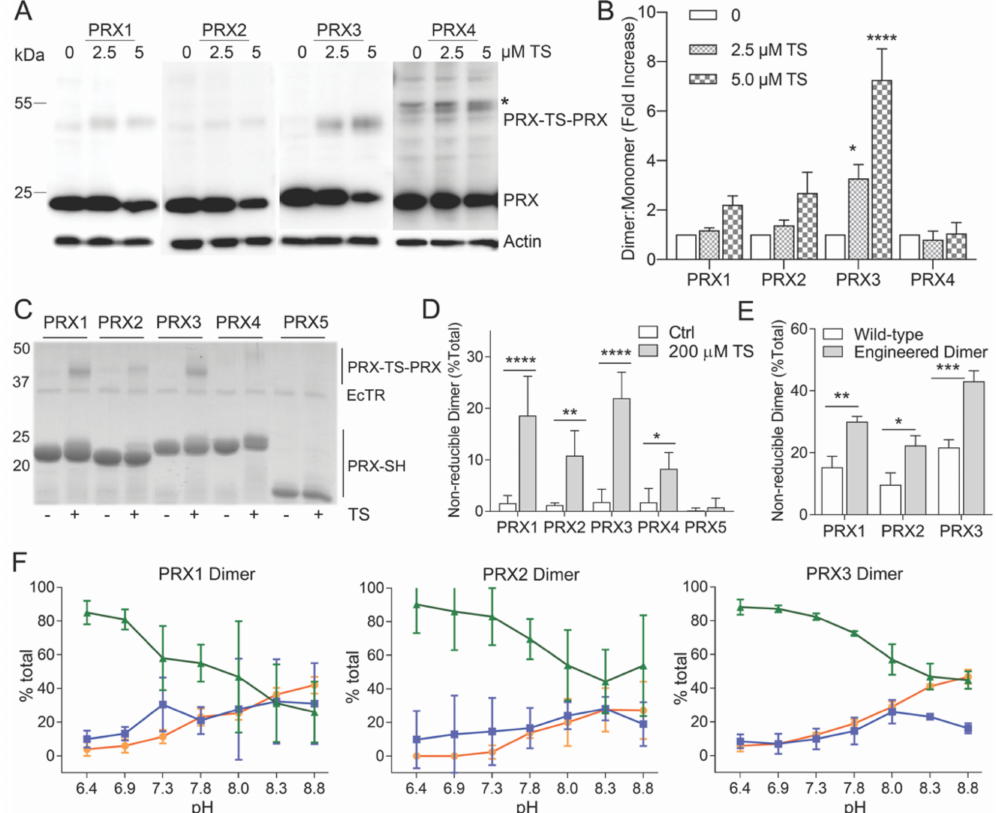
Figure 3. Specificity of TS for cellular and recombinant mitochondrial PRX3. ( A ) Western blots of PRXs 1–4 from MM tumor cells (HM cell line) incubated with indicated concentrations of TS for 24 h. Lysates were run on reducing SDS-PAGE gels (* = PRX-TS-PRX indicated the TS-mediated, cross-linked dimer, * = non-specific band in PRX4 sample). ( B ) Quantification of PRXs 1–4 covalent crosslink by TS in MM tumor cells ( n = 3). Significance is shown relative to no TS control for each PRX. ( C ) Human PRXs 1–5 (100 µ M) were cycled at 37 ◦ C at pH 8 in the presence or absence of 50 µ M TS, 5 µ M E.